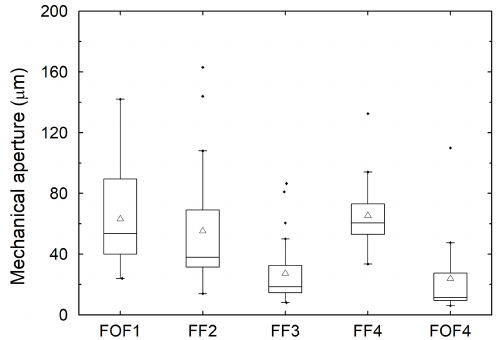
Figure 7. Mechanical apertures of the samples derived from image series taken on the top and bottom end faces with the microscope camera (MC). Individual symbols (black dots) above the whiskers represent measured data but are statistical outliers. In the box plots, the boxes signify the lower and upper quartiles (Q1 and Q3) of the datasets, respectively. The upper and lower whiskers indicate the largest and smallest data values for Q3 + 1.5 IQR and Q1 − 1.5 IQR, respectively, where IQR is the interquartile range equal to Q3 − Q1. The solid line and the open triangle in the box indicate the median and mean of each dataset,